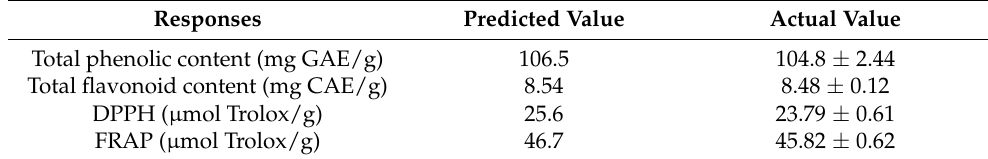
Figure 1. Response surfaces of ( A ) total phenolic compounds, ( B ) total flavonoids, ( C ) DPPH, and ( D ) FRAP as a function of UAE time and amplitude. Table 2. Actual and predicted response values at the optimal